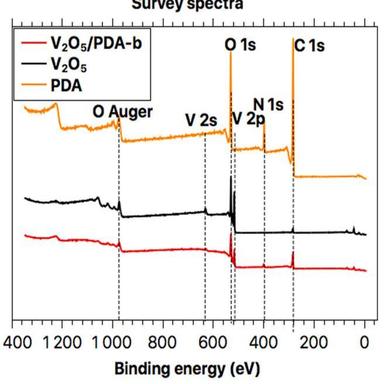
XPS survey spectra of V2O5/PDA-b, V2O5 and polydopamine (PDA).